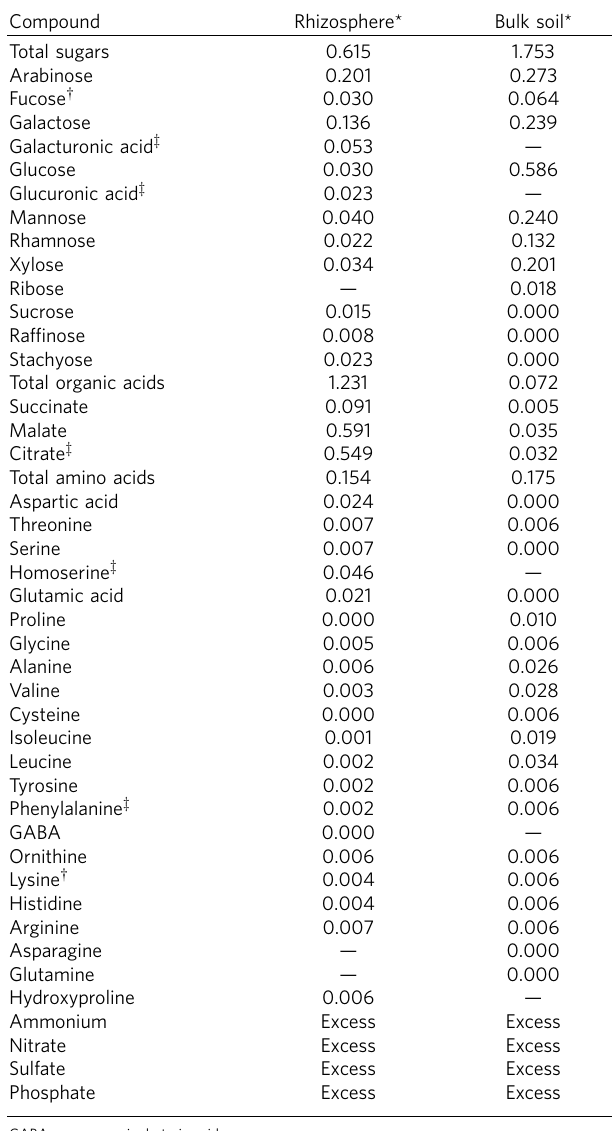
GABA, gamma-aminobutyric acid. *Values represent the molar ratio of the compounds, with the sum of all compounds in each environment equalling 2. —, no information. w Excluded from the in silico representation as the model fails to grow on these compounds. z Excluded from the in silico representation as S. meliloti does not grow with these